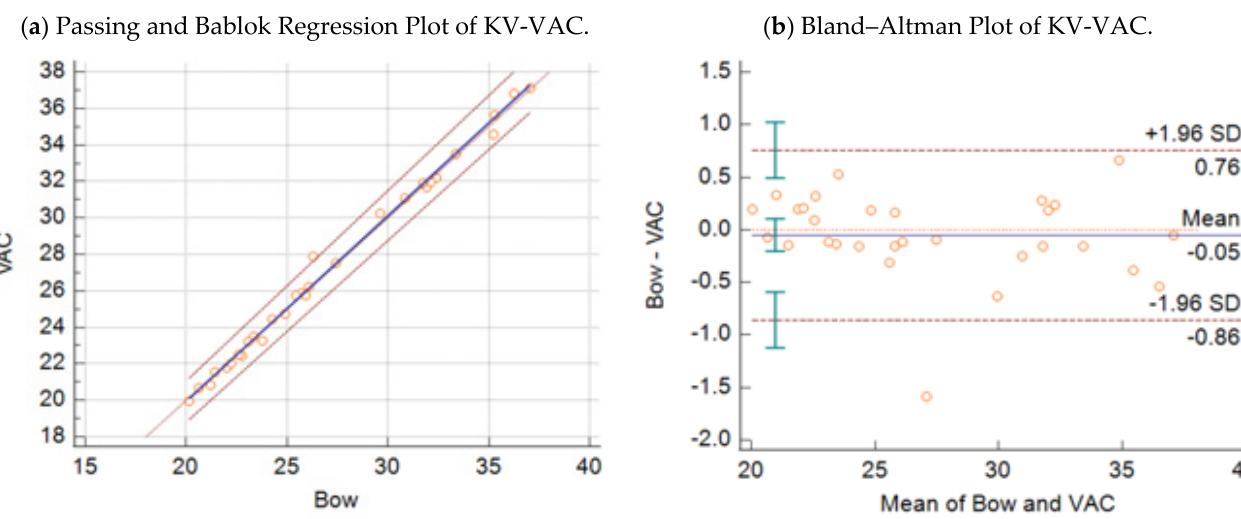
Figure 2. ( a ) Passing–Bablok regression plot: comparison of Ct values obtained with the KV-VAC Scheme 95. CI in 30 samples. ( b ) Bland–Altman plot: comparison of Ct values obtained with the KV-VAC strain assay vs. Capripox-specific real-time PCR Bowden assay, with 95% CI in 30